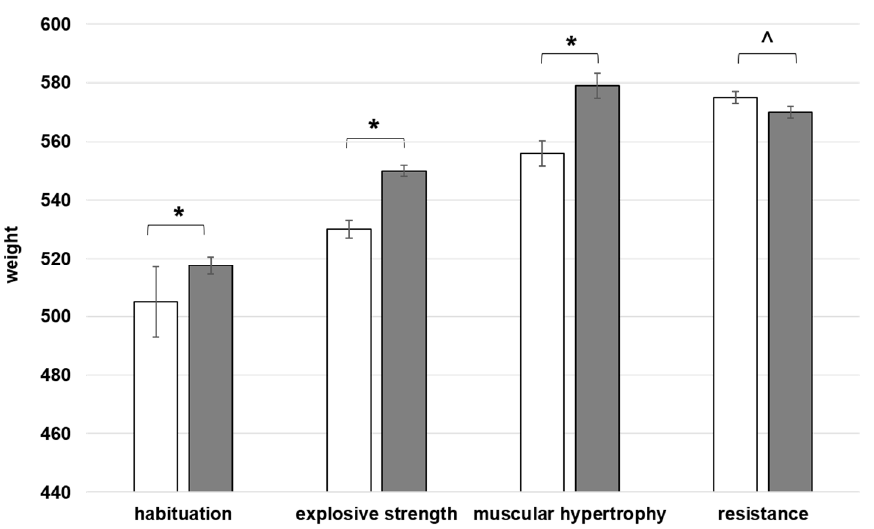
Figure 1. The trend of Peregrine × Lanner falcon’s weight (measured before and after each session) during the high ‐ tech training. Each step of the training consisted of different sessions, at a distance of 48 h. Median value ± standard error of the raptor’s weight gained during the entire high ‐ tech training, composed of four different workouts. Comparison between the results of the 1st (white bins) vs. the 2nd week (grey bins) of each regimen. Wilcoxon test for non ‐ parametric data, results are given as a range * W = 0, p < 0.001; ^ W = 1.5 p > 0.2.